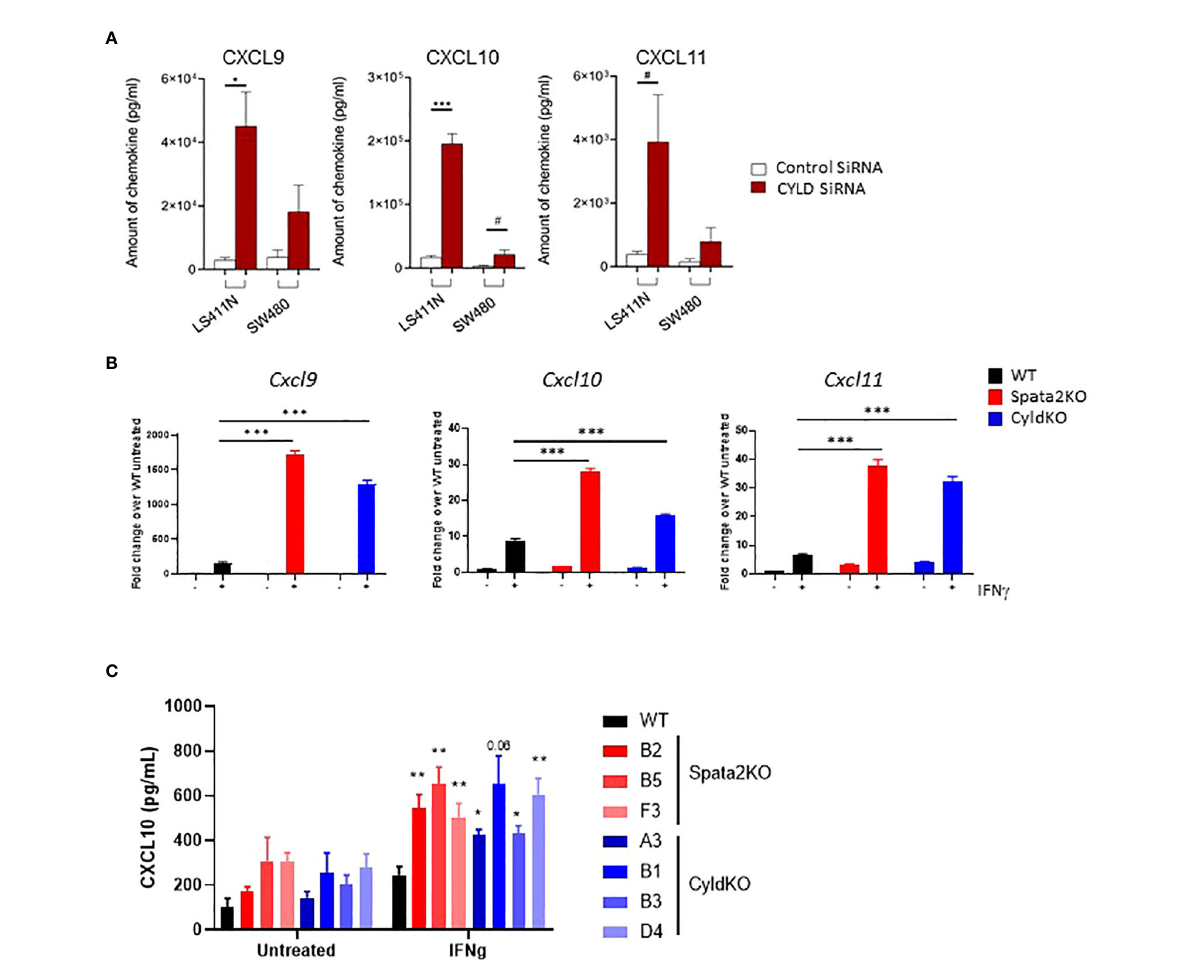
FIGURE 2 SPATA2 and CYLD inhibit CXCL9, CXCL10 and CXCL11 expression in human and mouse cancer cell lines. (A) Indicated human colon cancer cell lines were transfected with siRNA directed against CYLD . CXCL9, CXCL10 and CXCL11 protein levels were measured in the conditioned media of IFN- g -stimulated cells by Luminex. Absolute protein levels are represented. Data are representative of 3 independent experiments. * p<0.05, *** p<0.001, # p<0.1 (Paired Student ’ s t test). (B) Cxcl9 , Cxcl10 , and Cxcl11 gene expression were measured at the indicated time points following IFN- g stimulation. Spata2 -KO clone B5 and Cyld -KO clone D4 are represented. Results are representative of 1 out of 2 independent experiments. *** p<0.001 (Paired Student ’ s t test of IFN- g -stimulated KO vs. WT cells). (C) CXCL10 protein secretion from WT vs. Spata2 -KO and Cyld -KO CT26 clones. Results are representative of 1 out of 2 independent experiments. * p<0.05, ** p<0.01 (Paired Student ’ s t test vs. IFN- g - treated WT cells). Mean ±